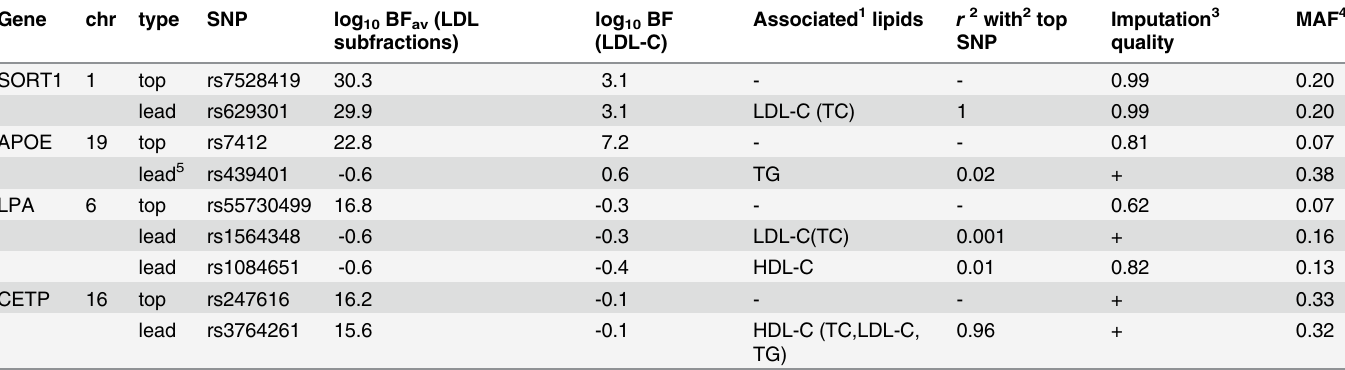
Table 2. Summary of the strongest associations with LDL subfractions in our